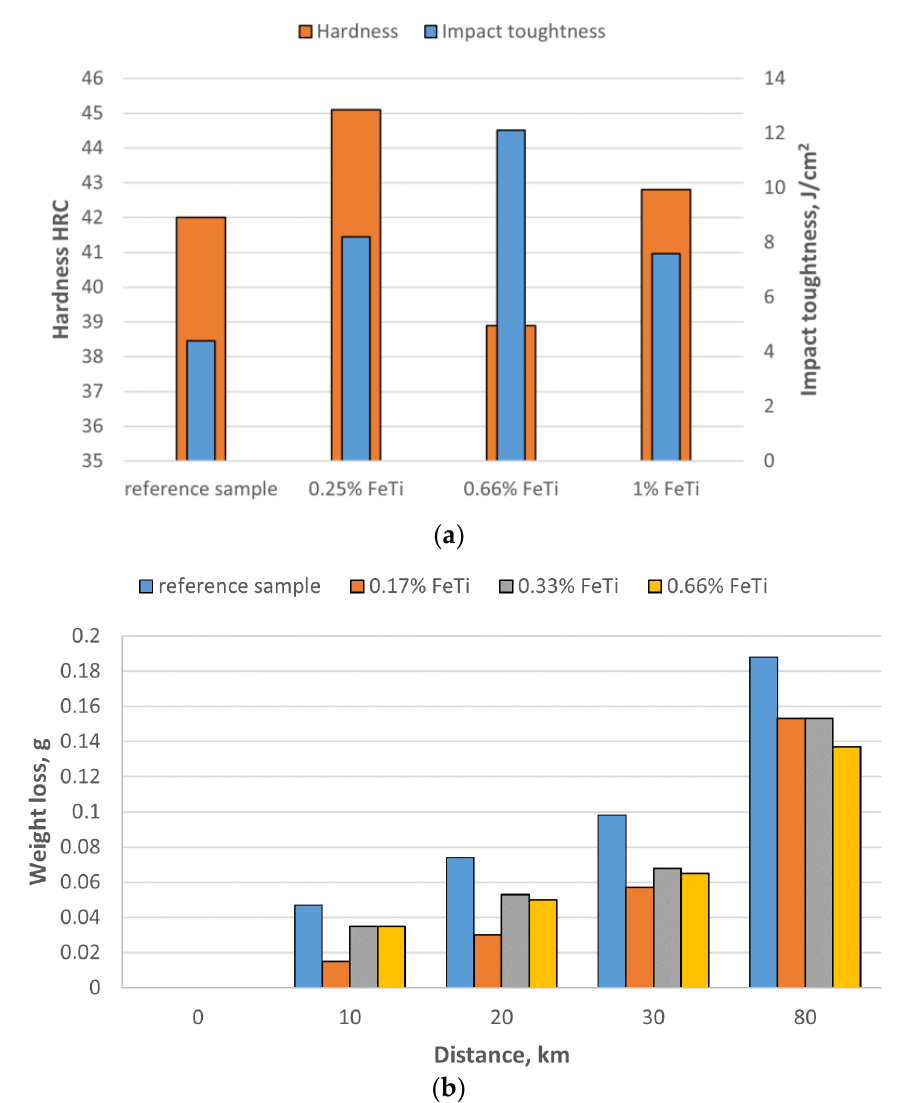
Figure 2. ( a ) Impact toughness and hardness of cast iron inoculated with Fe – Ti [22]; ( b ) results of wear resistance as function of distance [20].